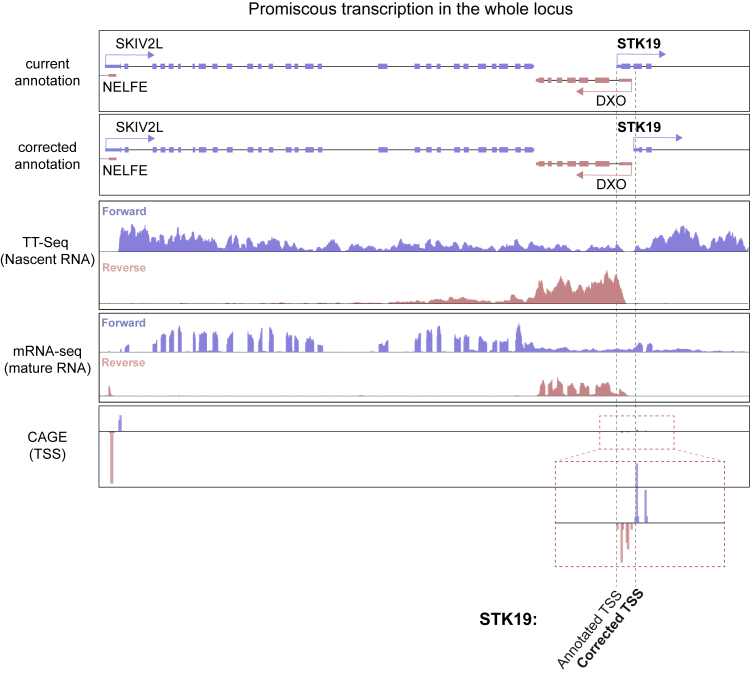
Promiscuous Transcription in the STK19 Gene Locus, Related to Figure 1STK19 and relevant surrounding genes are shown. Forward strand genes are shown in blue (SKIV2L and STK19) and reverse strand genes are in pink (NELFE and DXO). The current annotation is aligned with the corrected annotation, TT-seq and mRNA-seq data are from WT HEK293 cells (Gregersen et al., 2019), and CAGE data from the FANTOM project to show TSSs. Red dashed box shows zoom-in of CAGE data of the STK19 promoter region. Annotated TSS and corrected TSS are marked by dashed black lines.